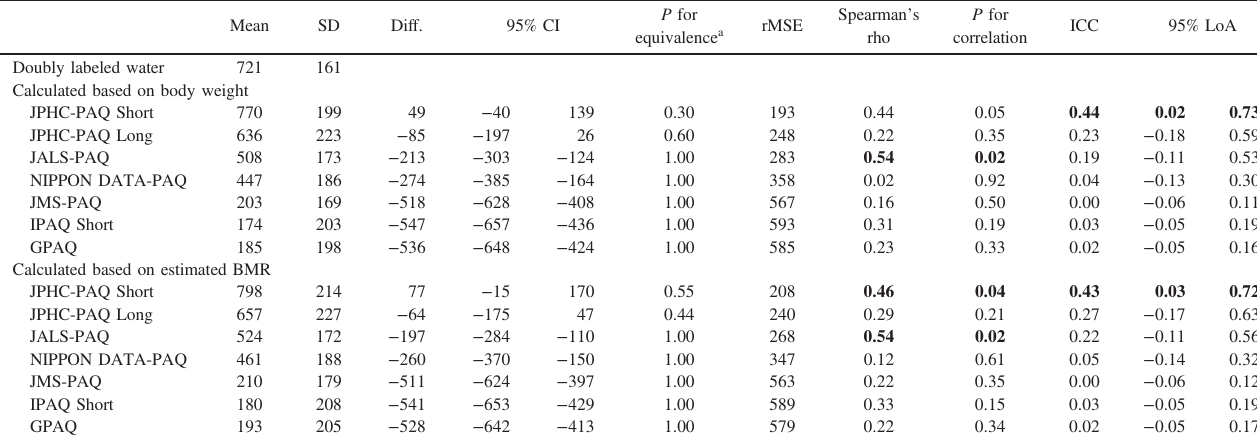
Table 3. Validity of seven physical activity questionnaires (PAQs) in estimating activity energy expenditure ( n =